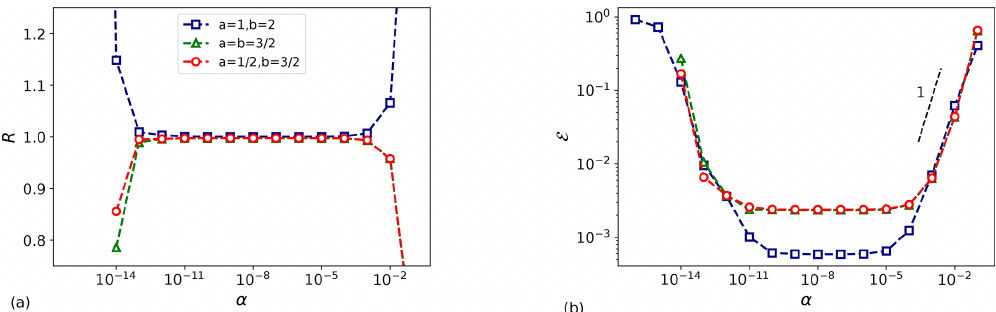
Figure A2. (a) Ratio and (b) relative error between adjoint and finite-difference-based gradients.